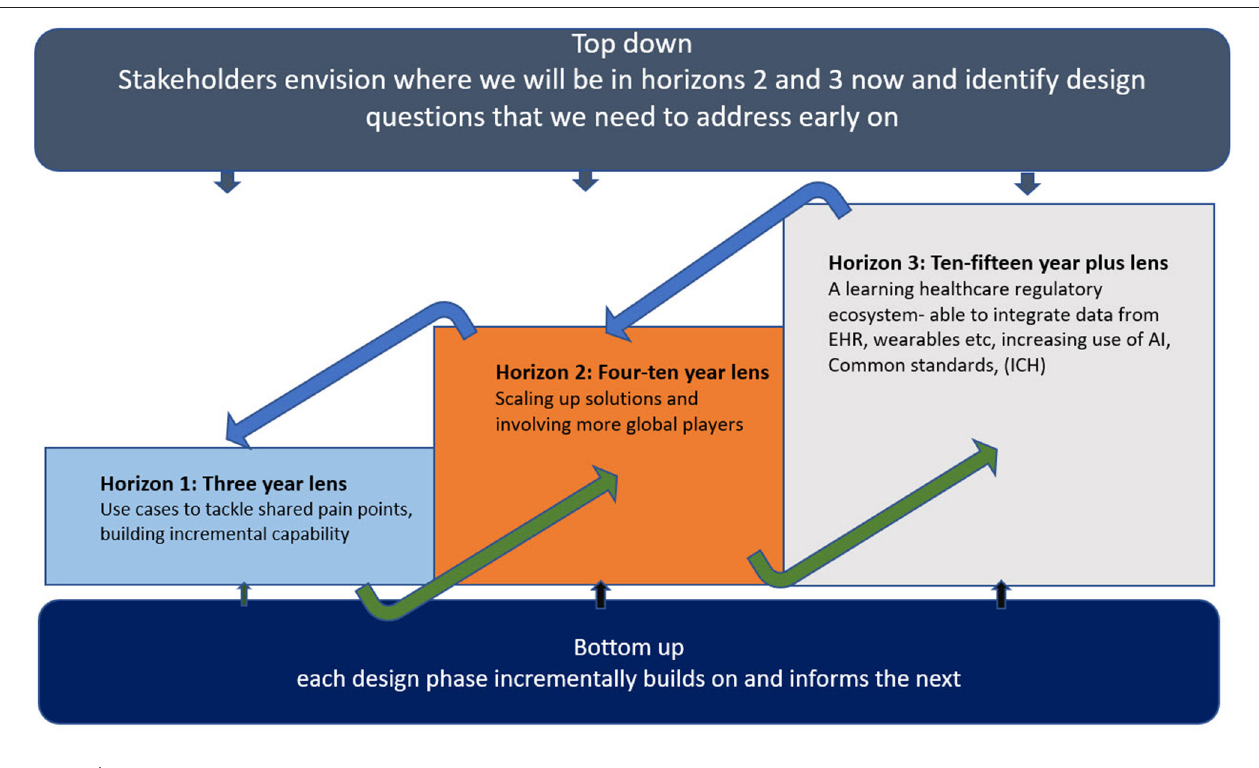
FIGURE 2 | Three horizons for transformative change.